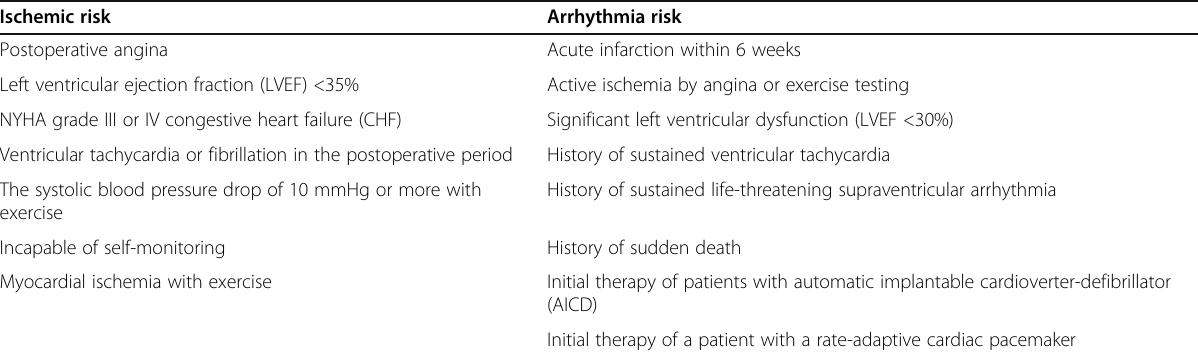
Table 1 Patients with high risk during cardiac rehabilitation [8] Ischemic risk Arrhythmia risk